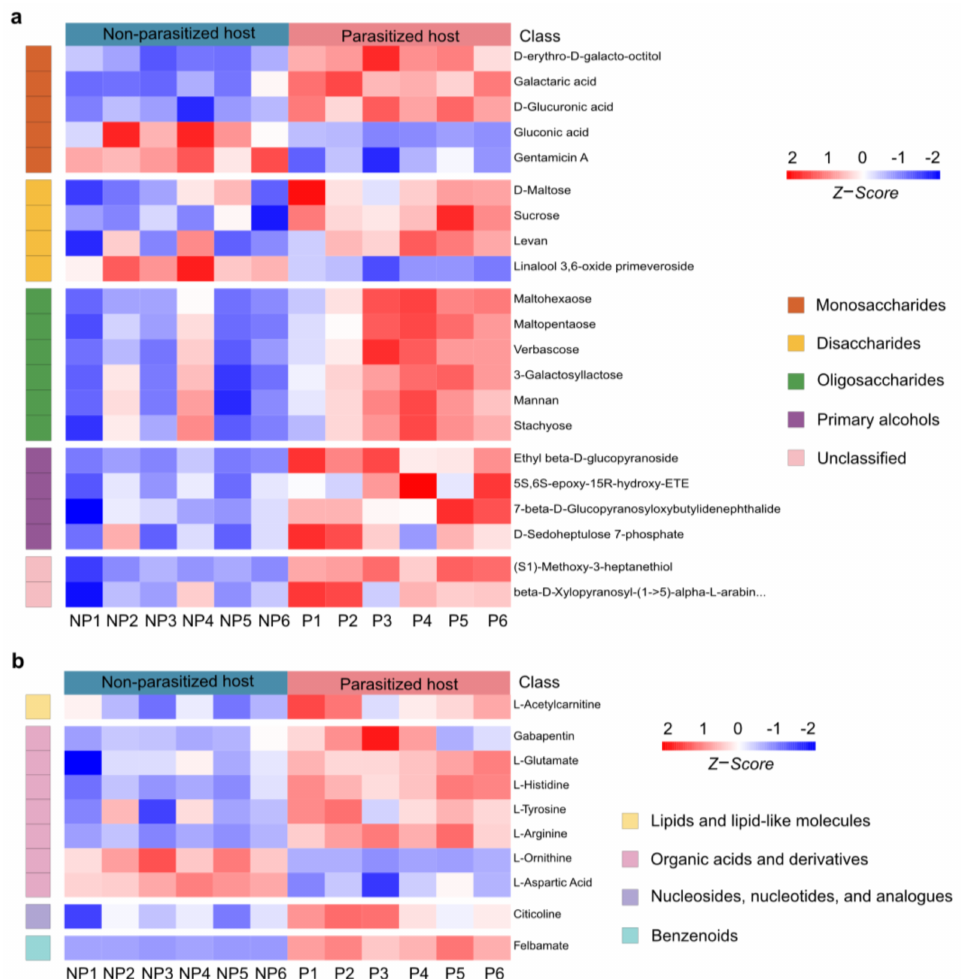
Figure 5. Changes in organic oxygen compounds and neuromodulators post A. japonica parasitization. ( a ) Heatmap of the groups of organic oxygen compounds changing in parasitized and non-parasitized hosts. ( b ) Heatmap for comparison of neuromodulators between parasitized and non-parasitized hosts. Each column represents one NP or P sample, and each row represents one differentially expressed metabolite. The Z-score of each sample is plotted according to the red–blue color scale. The red and blue colors indicate high abundance and low abundance, respectively. Abbreviations: NP, non-parasitized host; P, parasitized